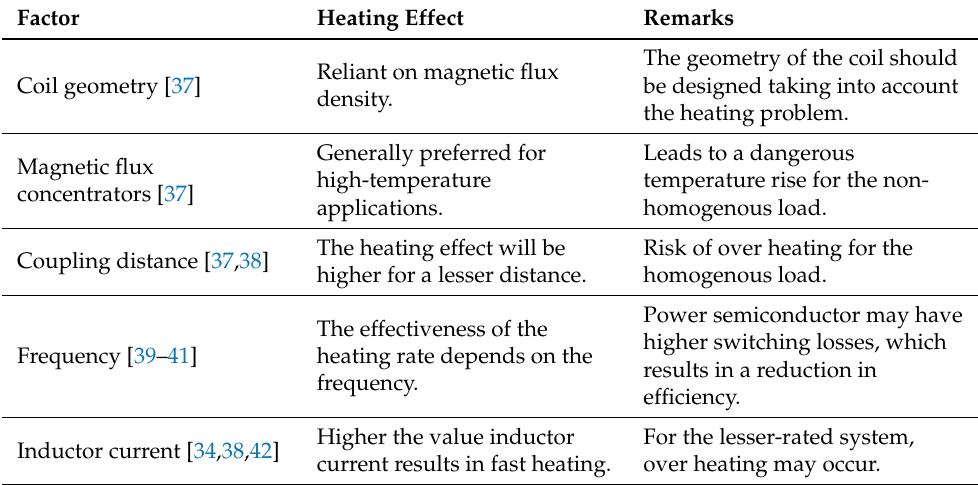
Table 1. Effect of the load parameters in IH.